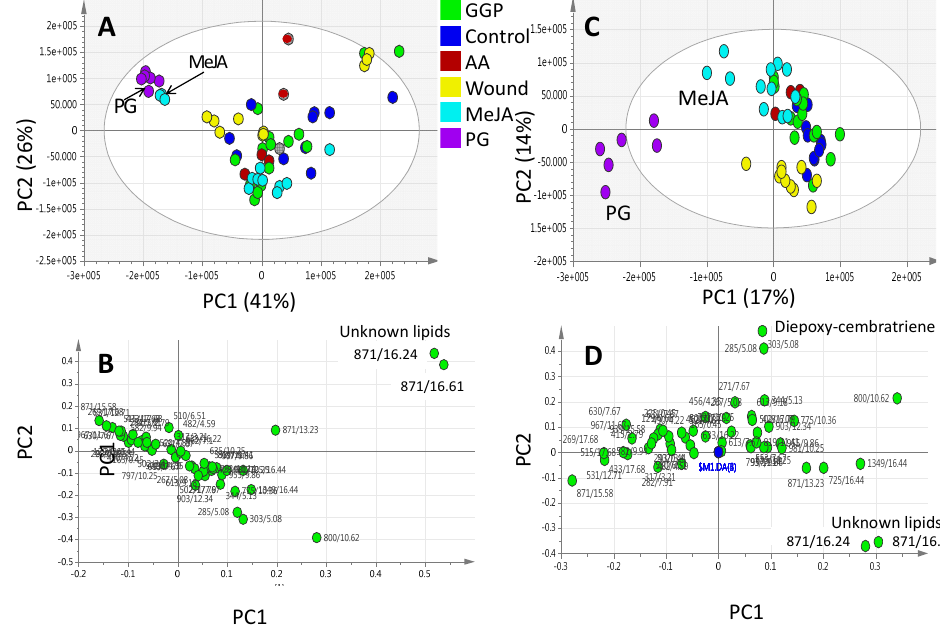
Figure 3. Principal component analysis (PCA) and orthogonal projection to latent